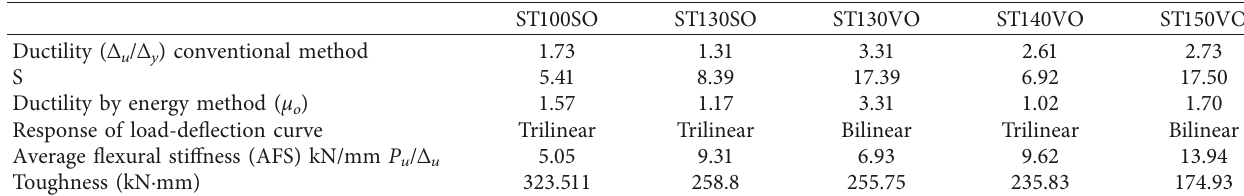
Table 4: Ductility and toughness indices.